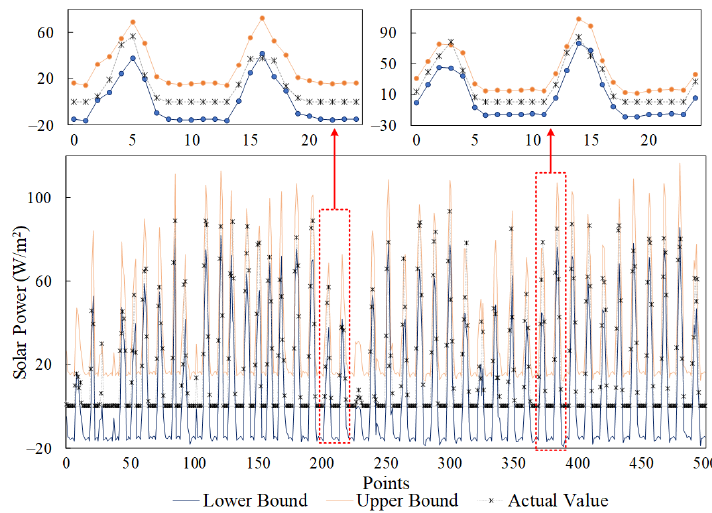
Figure 12. The prediction result obtained by HS with WI w/ ELM-AE.